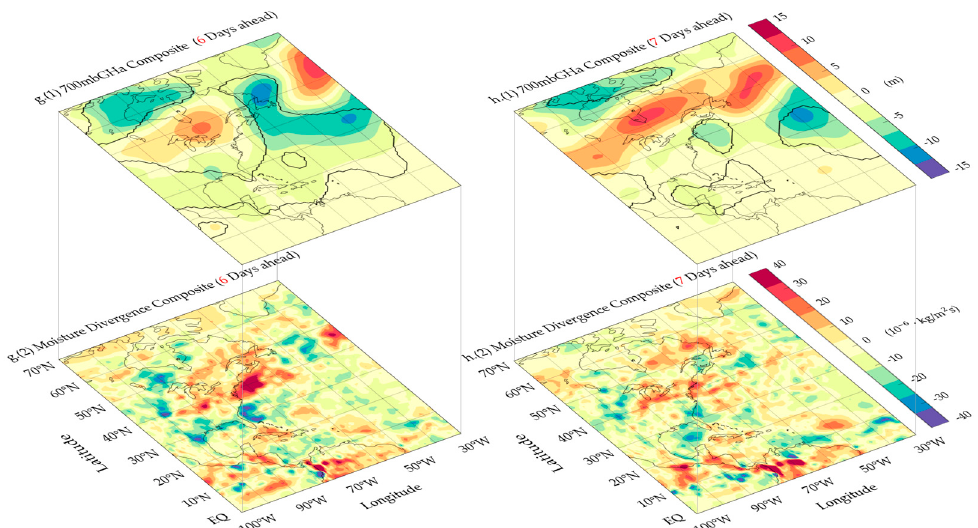
Figure 9. The evolutions of the associated anomalous ( 1 ) atmospheric circulation and ( 2 ) moisture flux during the top 5% extreme precipitation periods using the 700 GHa and VIMFa composites for the Mississippi river basin from 7 days ahead ( h ) to the extreme precipitation days ( a ). The regions with statistical significant values at the 95% level are circled by the thick black lines.